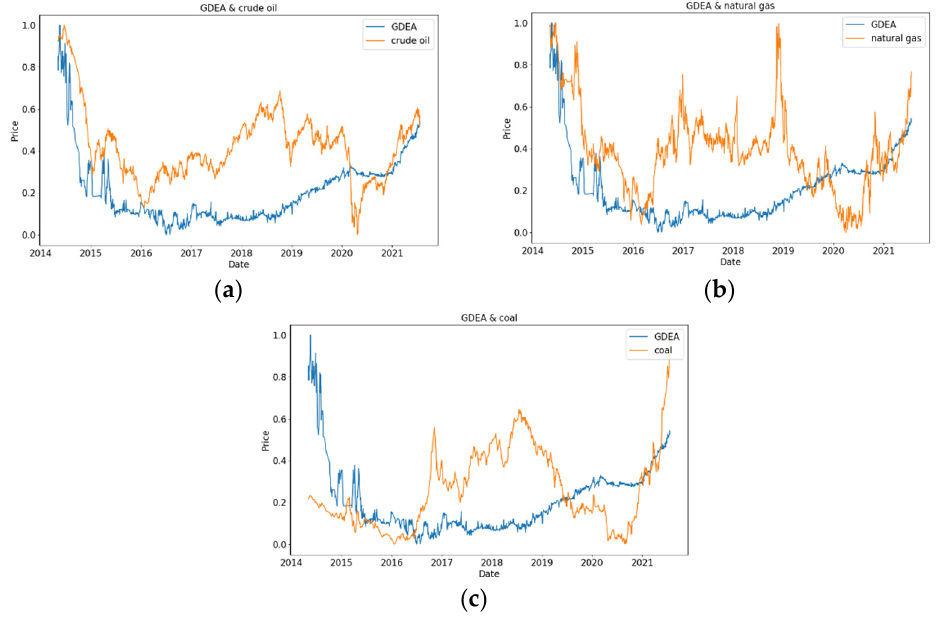
Figure 4. GDEA compared with the energy analysis. ( a ) GDEA and crude oil; ( b ) GDEA and natural gas; ( c ) GDEA and coal.